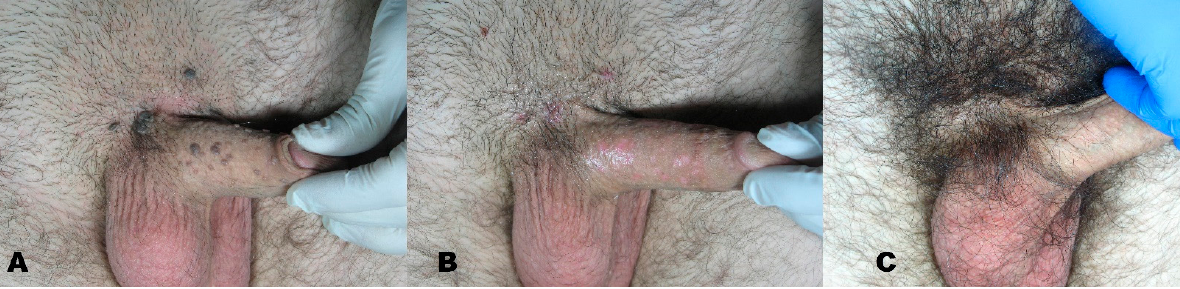
Figure 9. ( A ) Condyloma acuminata before treatment. ( B ) region right after removal with Erbium laser. ( C ) Area at 6-month follow-up.